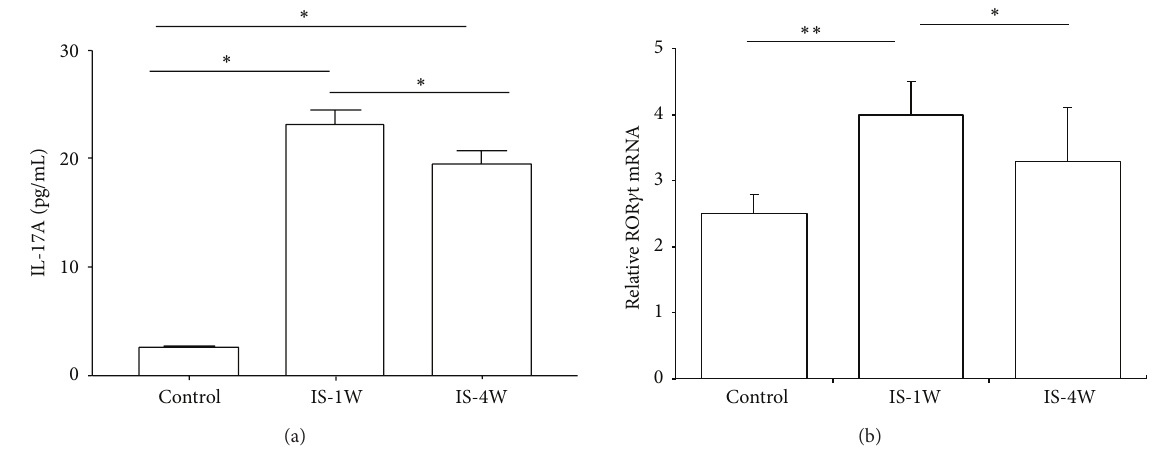
Figure 1: Circulating IL-17A levels and ROR 𝛾 t mRNA expression were increased in IS patients. (a) Plasma IL-17A protein level. The plasma samples were obtained from IS patients and control subjects at 7 and 28 days after stroke and analyzed using ELISA. (b) ROR 𝛾 t mRNA levels in PBMCs were obtained from IS patients. The lymphocytes were isolated through the Ficoll-Hypaque separation of the peripheral blood obtained from 30 control subjects and 50 IS patients at 7 and 28 days after stroke. Total RNA was extracted from the PBMCs and the ROR 𝛾 t mRNA expression levels in the PBMCs obtained from various groups were analyzed using real-time PCR. All mRNA expression values were normalized to GAPDH. ∗ 𝑃 < 0.05 and ∗∗ 𝑃 < 0.01 , compared with the controls. IS-1W = 1 week after IS; IS-4W = 4 weeks after